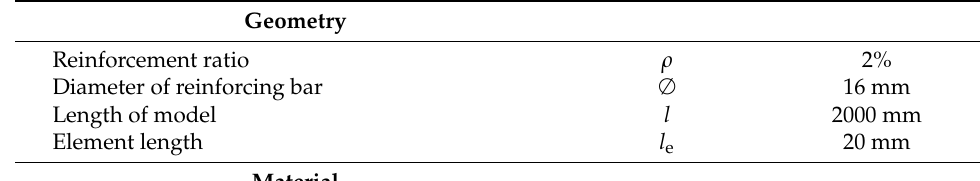
Figure 12. Iterative calculation procedure for the CPM. Table 2. CPM parameters for the case example.